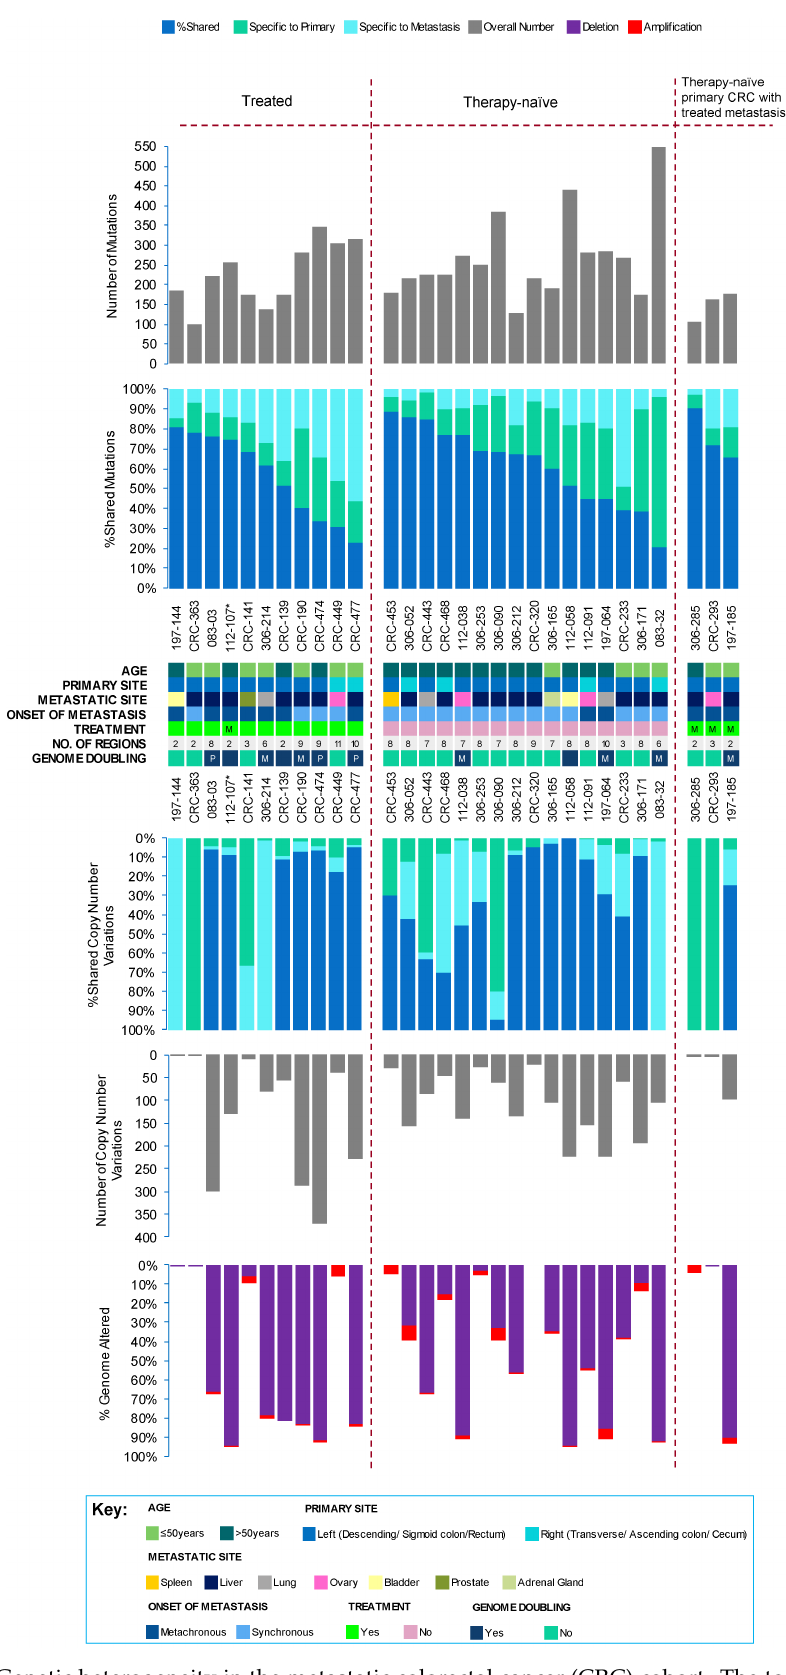
Figure 1. Genetic heterogeneity in the metastatic colorectal cancer (CRC) cohort. The total number of mutations (top panel), and copy number events, with percentage genome altered (bottom panel) detected in all tumour regions sampled per patient ( n = 30), with clinical details and markers, such